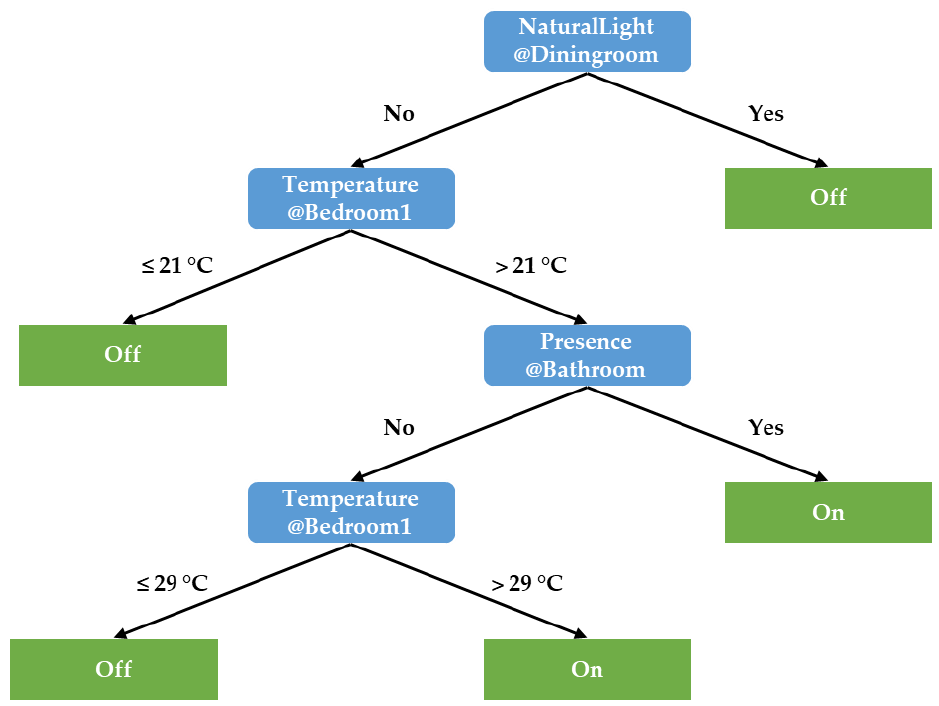
Figure 9. Decision tree for Bedroom 1 AC over Period 1.